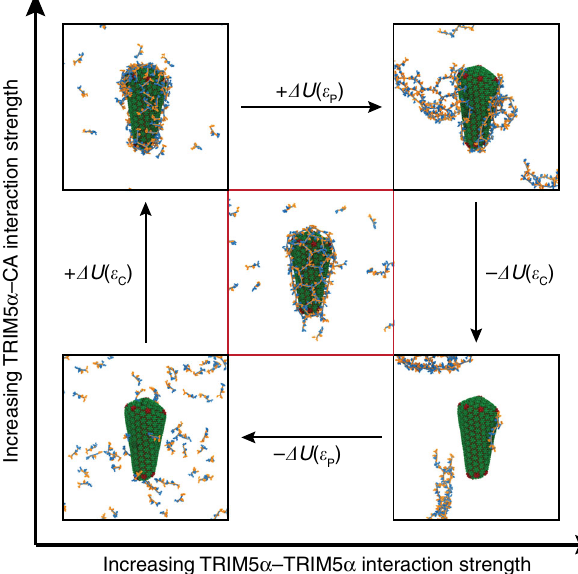
Fig. 3 A thermodynamic cycle depicts the phase behavior of TRIM5 α lattice assembly. ε P and ε C are parameters that tune the strengths of interactions between the protein – protein (TRIM5 α – TRIM5 α ) contacts of TRIM5 α and the protein – capsid (TRIM5 α – CA) contacts, respectively, in the potential energy. Panels are CG assembly simulations that proceeded to completion (~10,000 τ ) for: ε P = 0.5, ε C = 0.3 kcal/mol (Bottom Left); ε P = 1.2, ε C = 0.3 kcal/mol (Top Left); ε P = 1.2, ε C = 1.0 kcal/mol (Top Right); ε = 1.2, ε = 0.3 kcal/mol (Bottom Right) and ε = 0.7, ε = 0.35 kcal/mol P C P C (Center). Hexagonal assembly of TRIM5 α is critically balanced between ε P and ε C